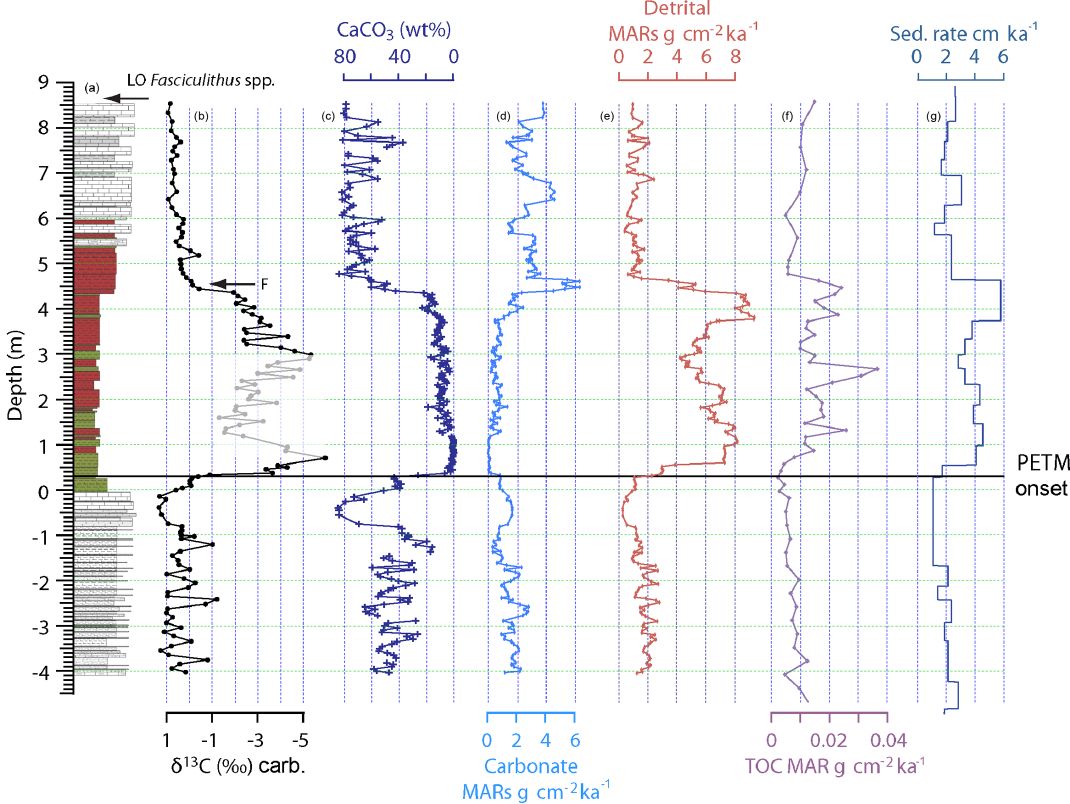
Figure 5. New carbonate, detrital and organic carbon mass accumulation and sedimentation rates for the Zumaia section: (a) lithological log produced during sample collection for this study (2011); (b) bulk carbonate δ 13 C; (c) weight percentage of CaCO 3 derived from XRF CaCO calibrated to discrete CaCO 3 analyses (see methods); (d) CaCO 3 mass accumulation rate; (e) detrital mass accumulation rate; (f) organic carbon accumulation rate; (g) linear sedimentation rates derived from the new cyclostratigraphic